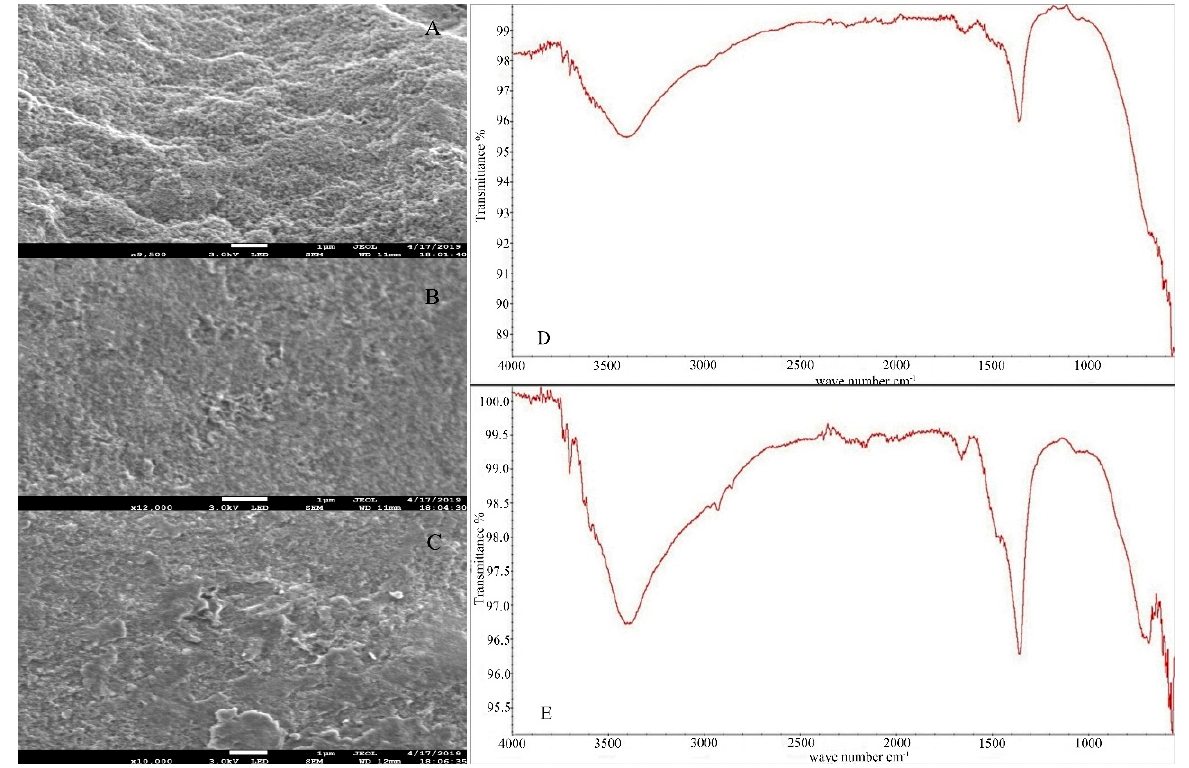
Figure 1. SEM images under 1 μ m ( A ): iowaite, ( B ): iowaite-NaAsO 2 , ( C ): iowaite-H 3 AsO 4 FT-IR spectra ( D ): iowaite-As; ( E ): iowaite.